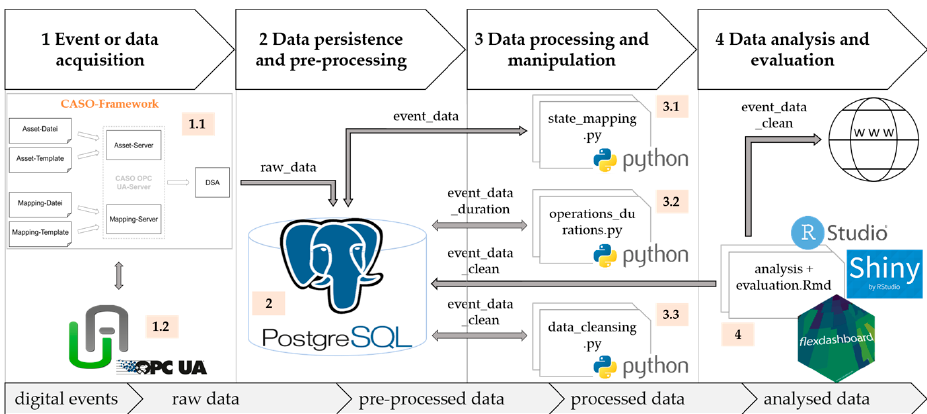
Figure 11. Data pipeline for the robotic assembly cell of the IIoT TB.